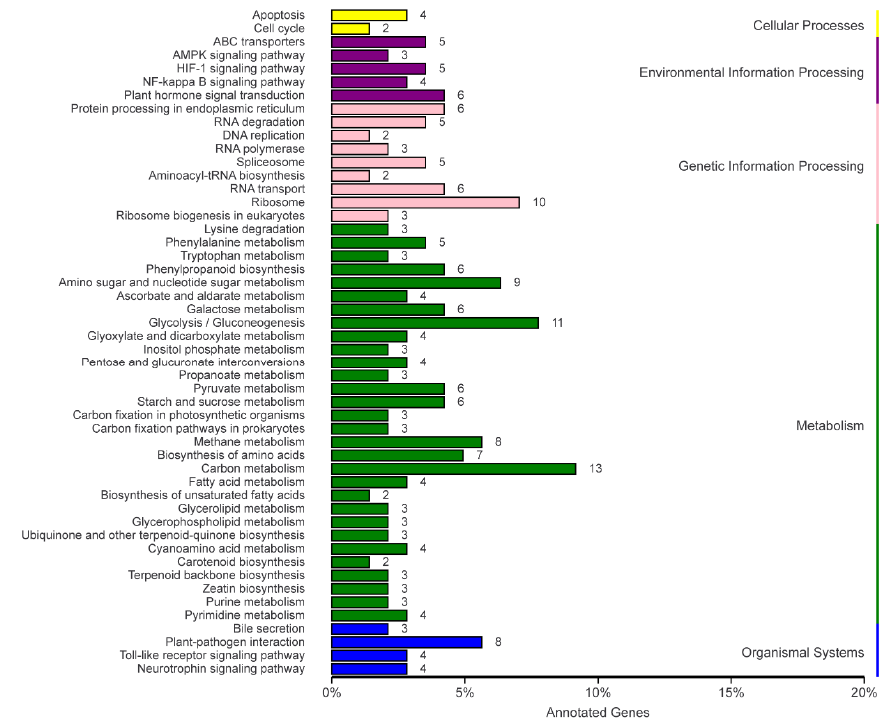
Figure 7. Kyoto Encyclopedia of Genes and Genomes (KEGG) classification of DEGs.